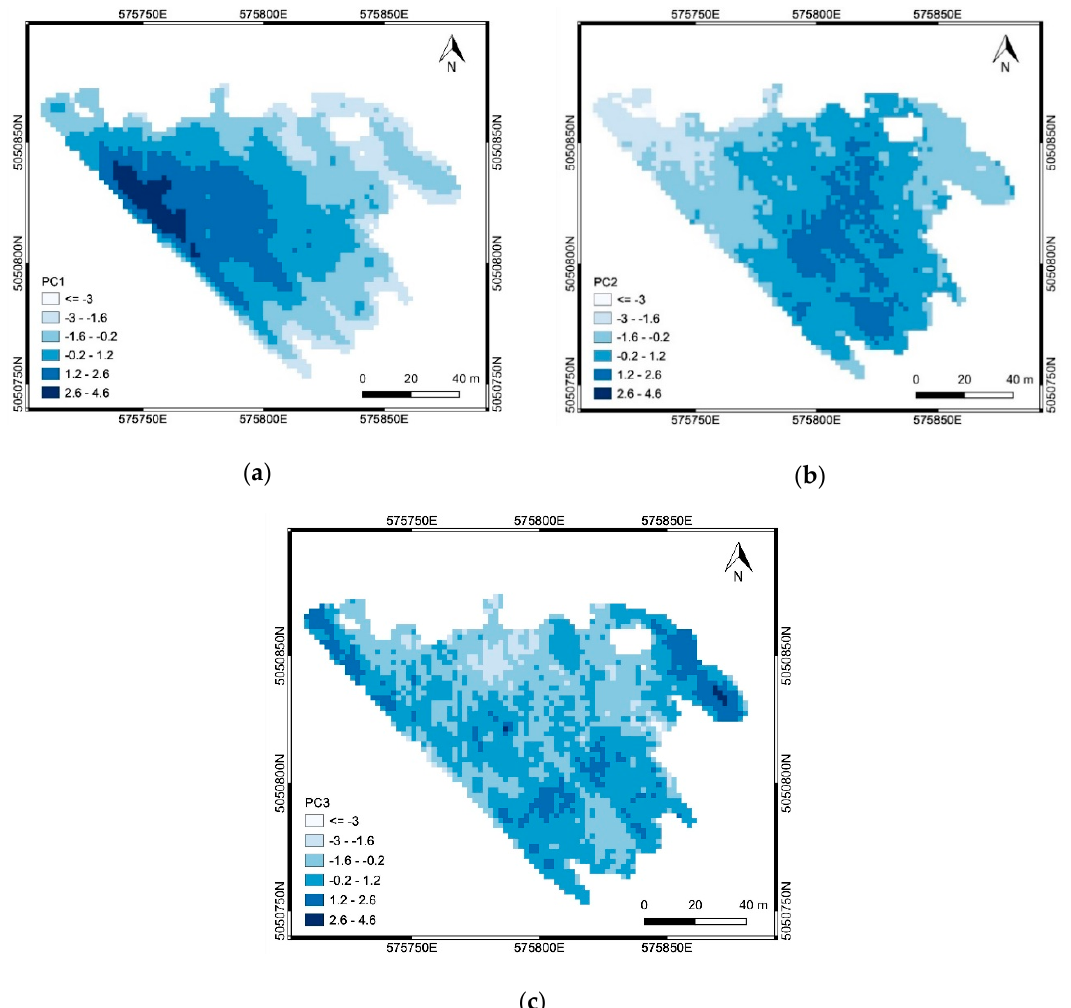
Figure 14. Distribution of the CWSI values within each SSMZ shown in Figure 12a: ( a ) SSMZ 1; ( b )